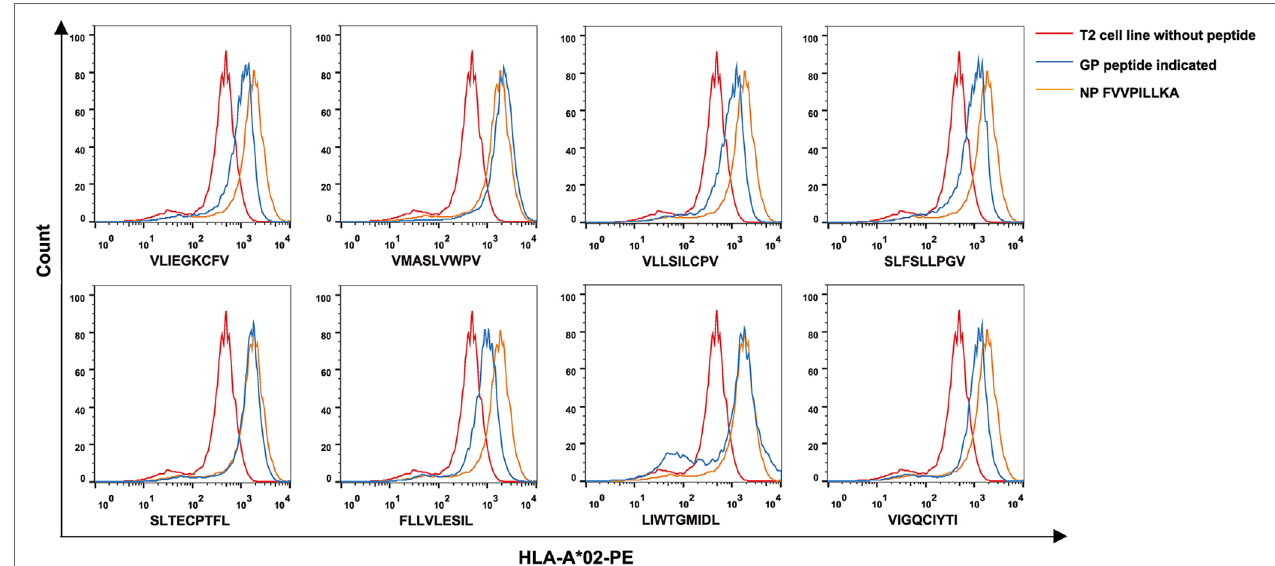
FigUre 1 | High binding affinity of eight Hantaan virus (HTNV) GP nonapeptides to HLA-A*0201 molecules. The T2 cell binding assay was used to quantify the peptide-binding affinity of 34 predicted HTNV GP nonapeptides to HLA-A*0201 molecules. T2 cells incubated with each peptide and β 2-microglobulin were then stained with phycoerythrin-labeled HLA-A*02 monoclonal antibody and detected by flow cytometry. The orange curves indicate HLA-A*0201 stabilization with HLA-A*0201-restricted HTNV NP FA9 (aa129–aa137, FVVPILLKA) peptides serving as positive controls. The red curves indicate T2 cells incubated without peptide serving as negative controls. The blue curves indicate T2 cells incubated with each HTNV GP nonapeptide. The overlay of the three conditions in histograms clearly show that the curve of T2 cells incubated with each of the eight HTNV GP nonapeptides was shifted more to the right with a higher fluorescence intensity of HLA-A*0201 molecules than those incubated without peptide, indicating that these nonapeptides have a high binding affinity to the HLA-A*0201 molecule. GP, glycoprotein; NP,